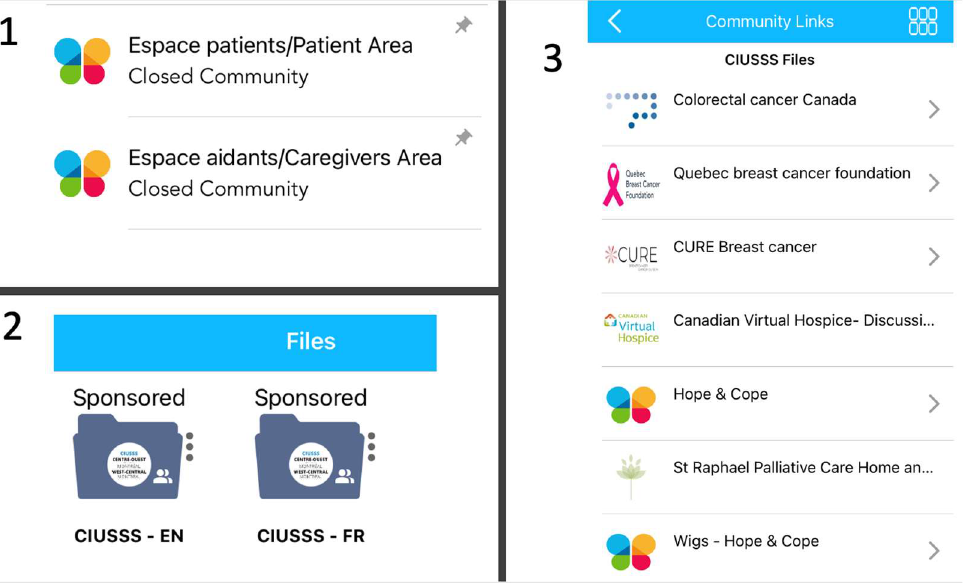
Figure 2. Content and features of the BELONG App for patients and caregivers closed community (1) and personal health files/resources (2 and 3).